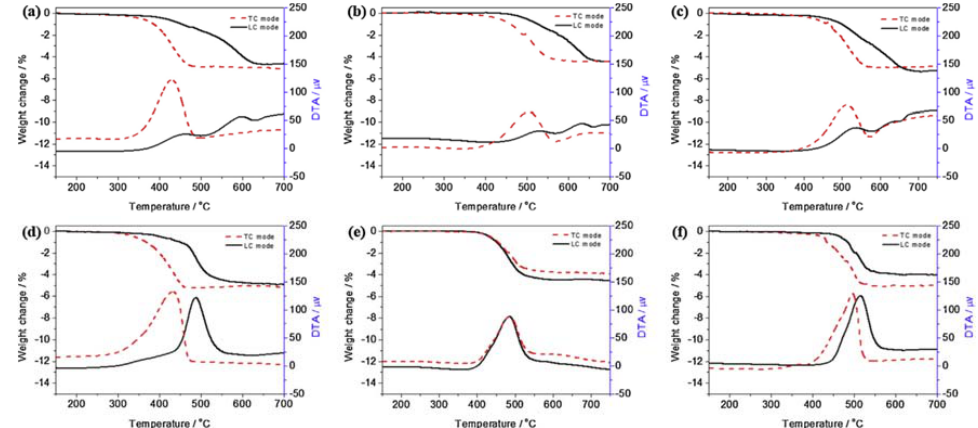
Figure 9. TG and DTG curves: ( a ) CeO 2 -500, ( b ) CeO 2 -800, ( c ) CeO 2 -1000, ( d ) Ag/CeO 2 -500, ( e ) Ag/CeO 2 -800, and ( f ) Ag/CeO 2 -1000. Reproduced from Ref. [47] with the permission from the Elsevier.